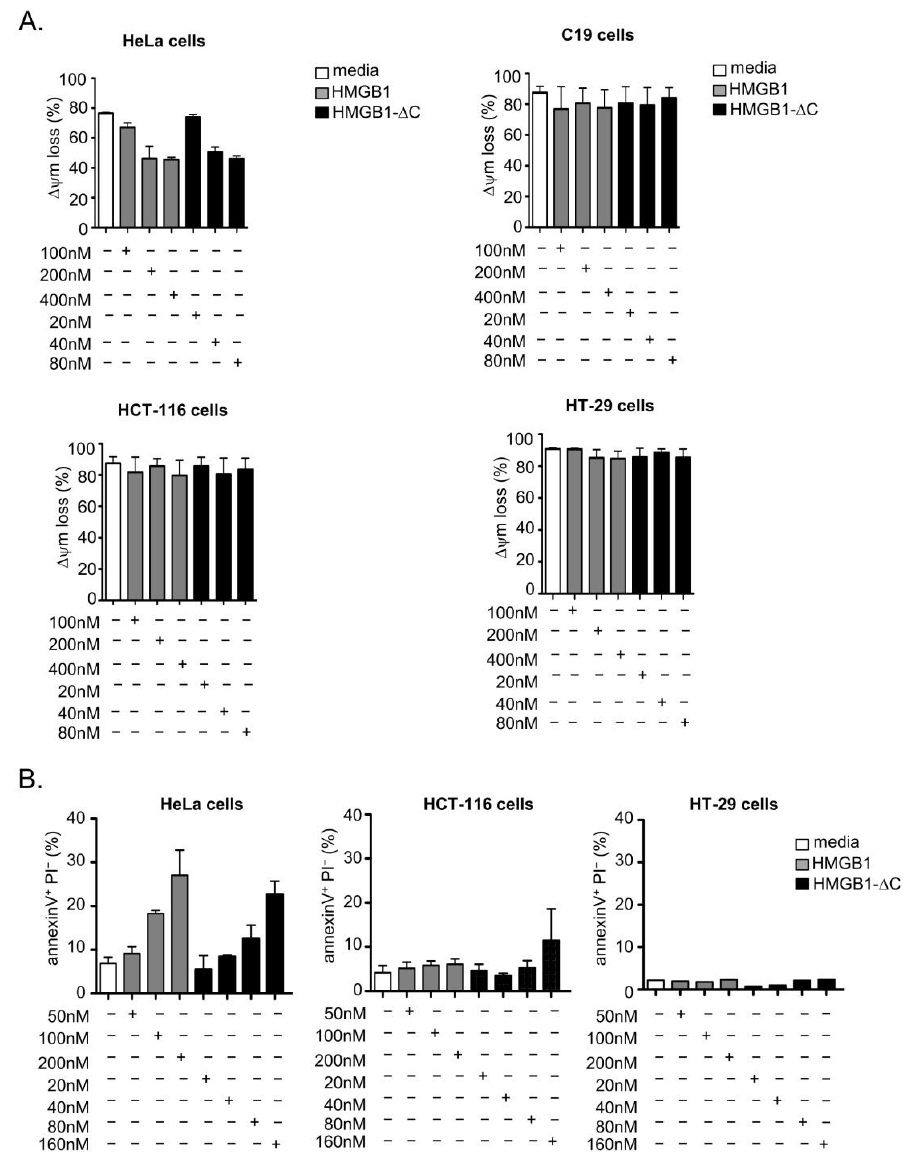
Figure 4. Mitochondrial membrane potential loss and apoptosis induction in cells treated with HMGB1-fl or HMGB1- ∆C. ( A ) The HeLa, HCT-116 and HT-29 carcinoma cells as well as the C19 fibroblastic cell line were treated for 48 h with increasing concentrations of HMGB1-fl (range: 100 – 400 nM) or HMGB1- ∆C (range : 20 – 80 nM). ∆ψ m was determined by labeling cells with DIOC6(3) and fluorescence intensities quantified by flow cytometry. ( B ) The HeLa, HCT-116 and HT-29 cells were treated for 96 h with increasing concentrations of HMGB1-fl (range: 50 – 200 nM) or HMGB1- ∆C (range : 20 – 160 nM) and labeled with Annexin V/PI. The percentage of early apoptotic cells (Annexin V + /PI − ) was determined by flow cytometry. Data are expressed as mean ± SD. SDs are indicated by error bars when they exceed symbol size.